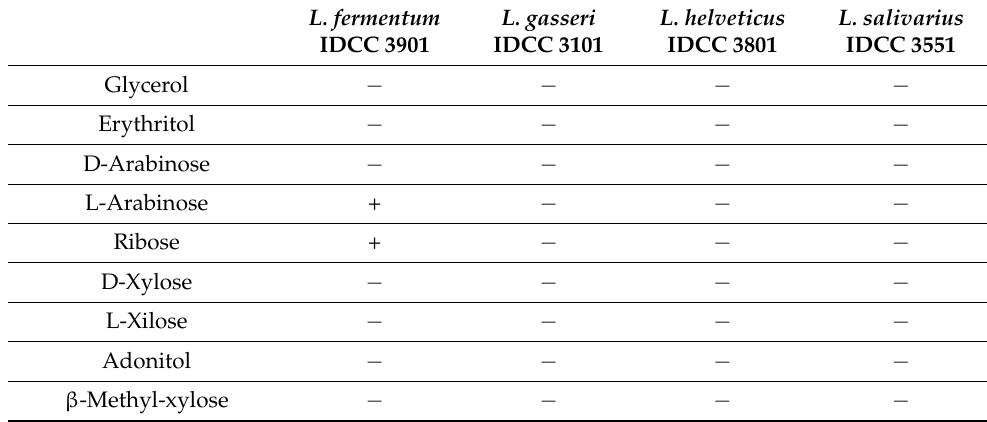
Table 6. API 50 CH test result of the four Lactobacillus strains tested in this